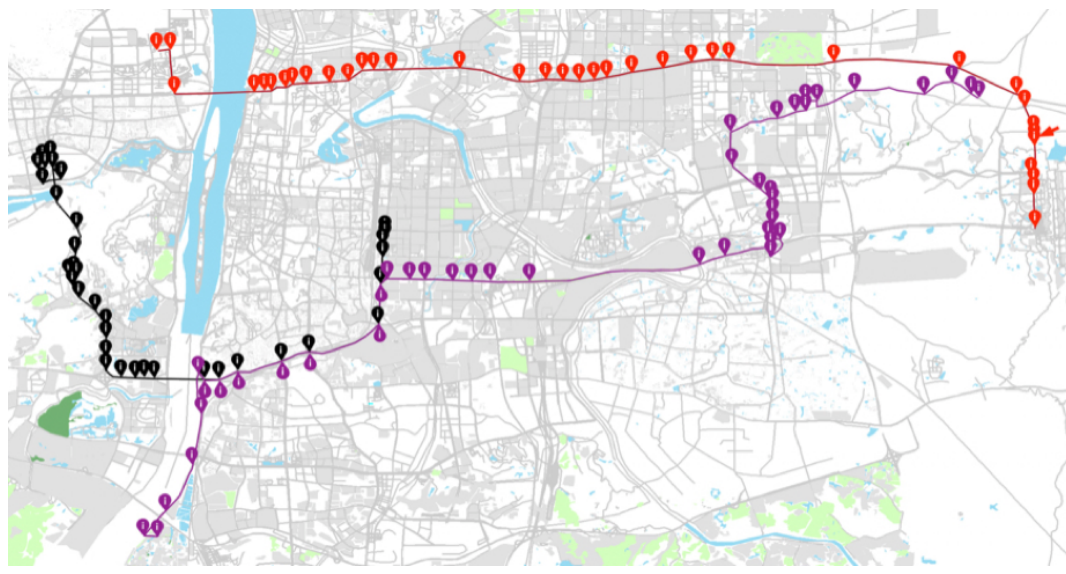
Figure 6. The image of four trajectories in Changsha (background obtained from OpenStreetMap (OSM)).